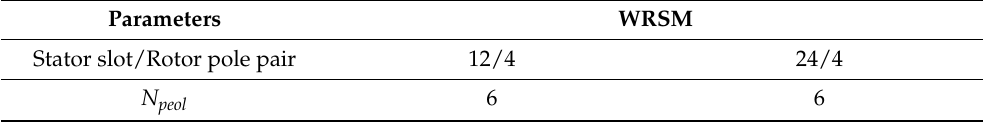
Table 4. Predicted N peol for the Analyzed